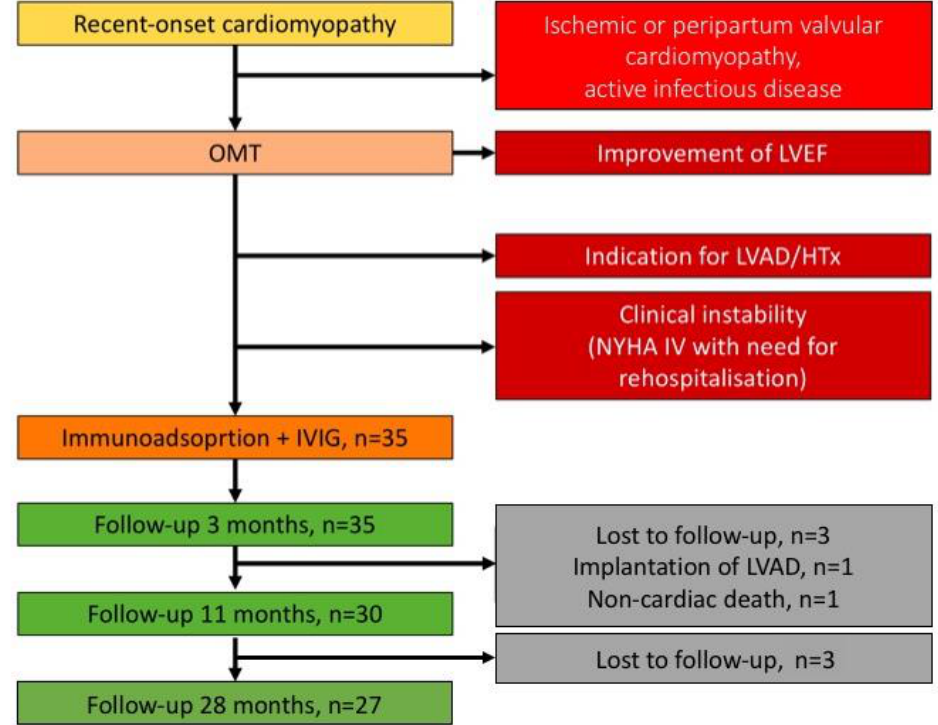
Figure 1. Study design diagram. HTx = heart transplantation.